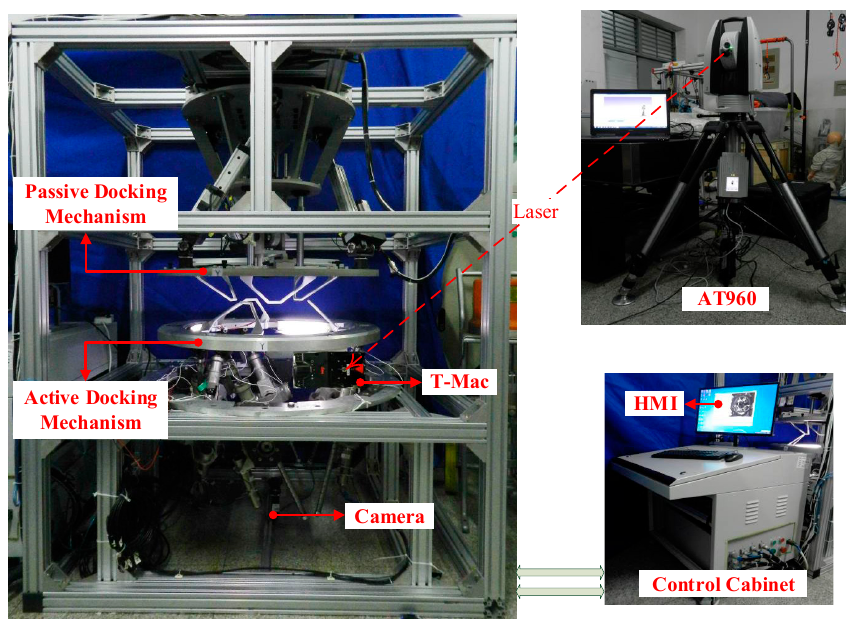
Figure 10. The semi-physical simulation platform. Table 2. Measurement uncertainties of the T-Mac 1.